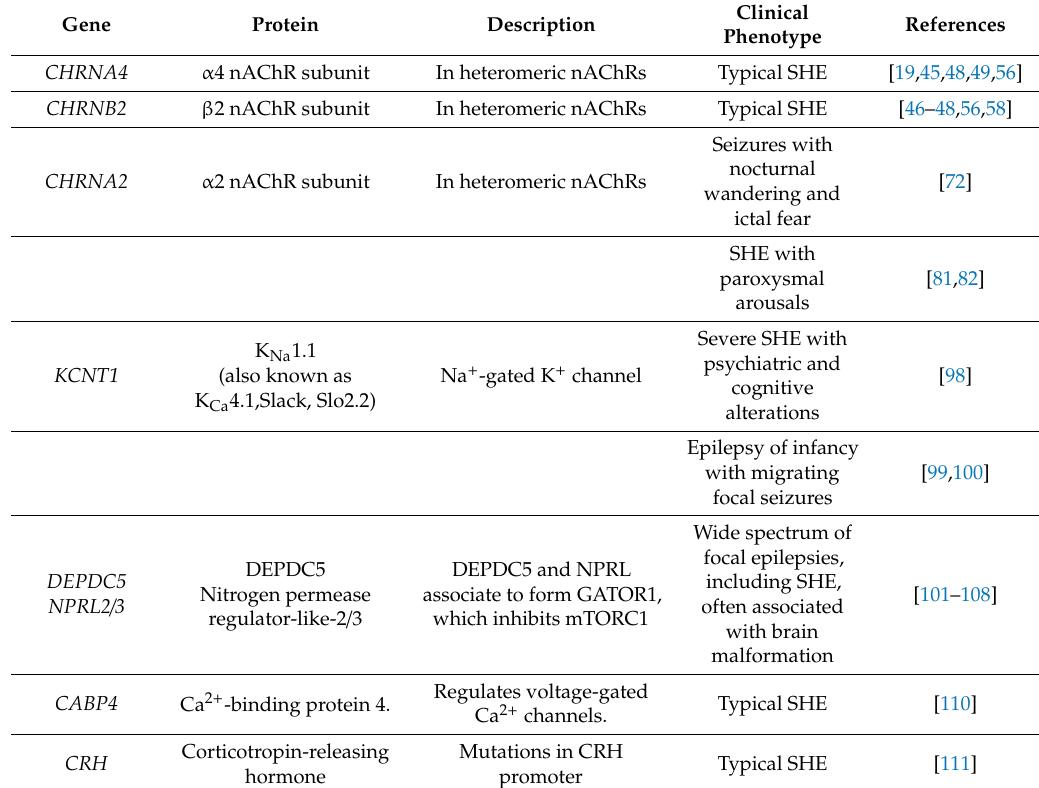
Identified or putative genes in autosomal dominant sleep-related hypermotor epilepsy